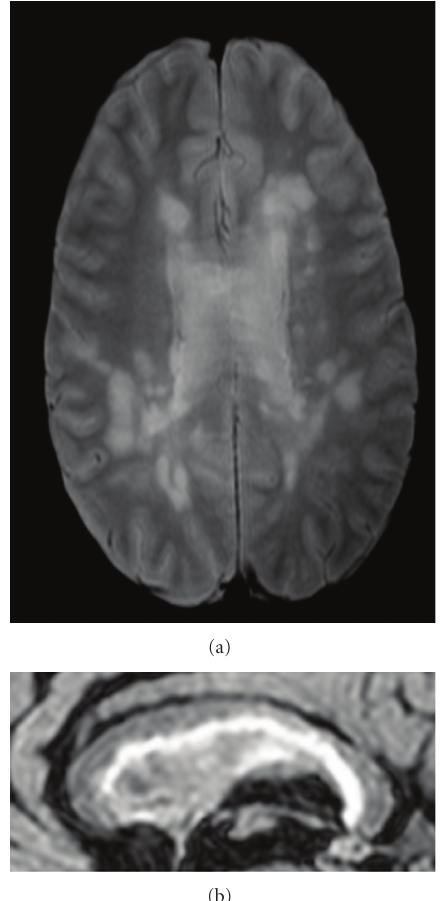
Figure 2: Female patient with high lesion load and no significant cognitive deficit. The PD axial image at the level of the body of the lateral ventricles and CC (a) shows lesions at the periventricular and subcortical white matter. The detail of mid-sagital FLAIR (b) shows the abundance of macroscopic lesion in the CC and callosal-septal